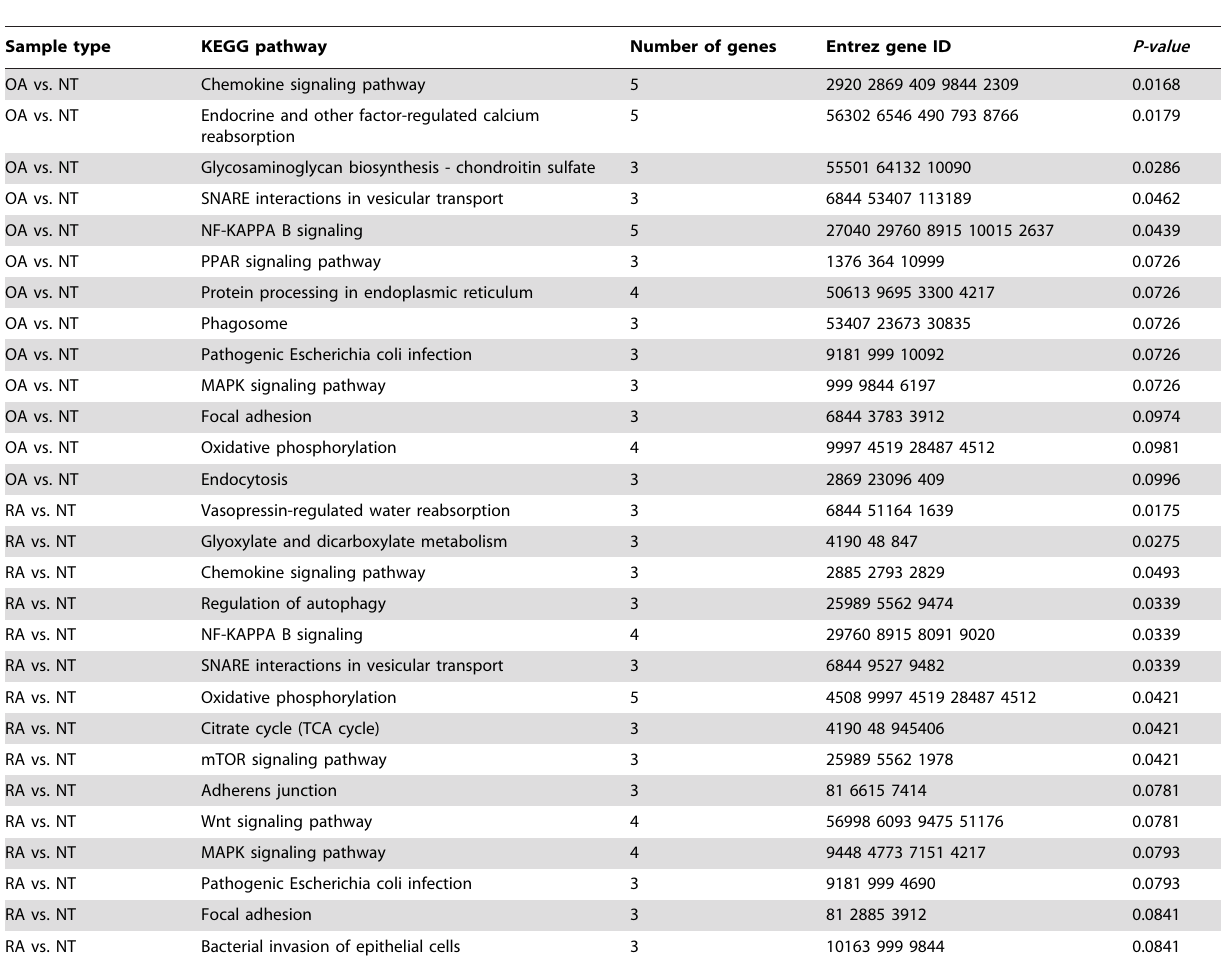
Table 4. KEGG pathway enrichment of genes differentially expressed RA and OA vs. NT samples.